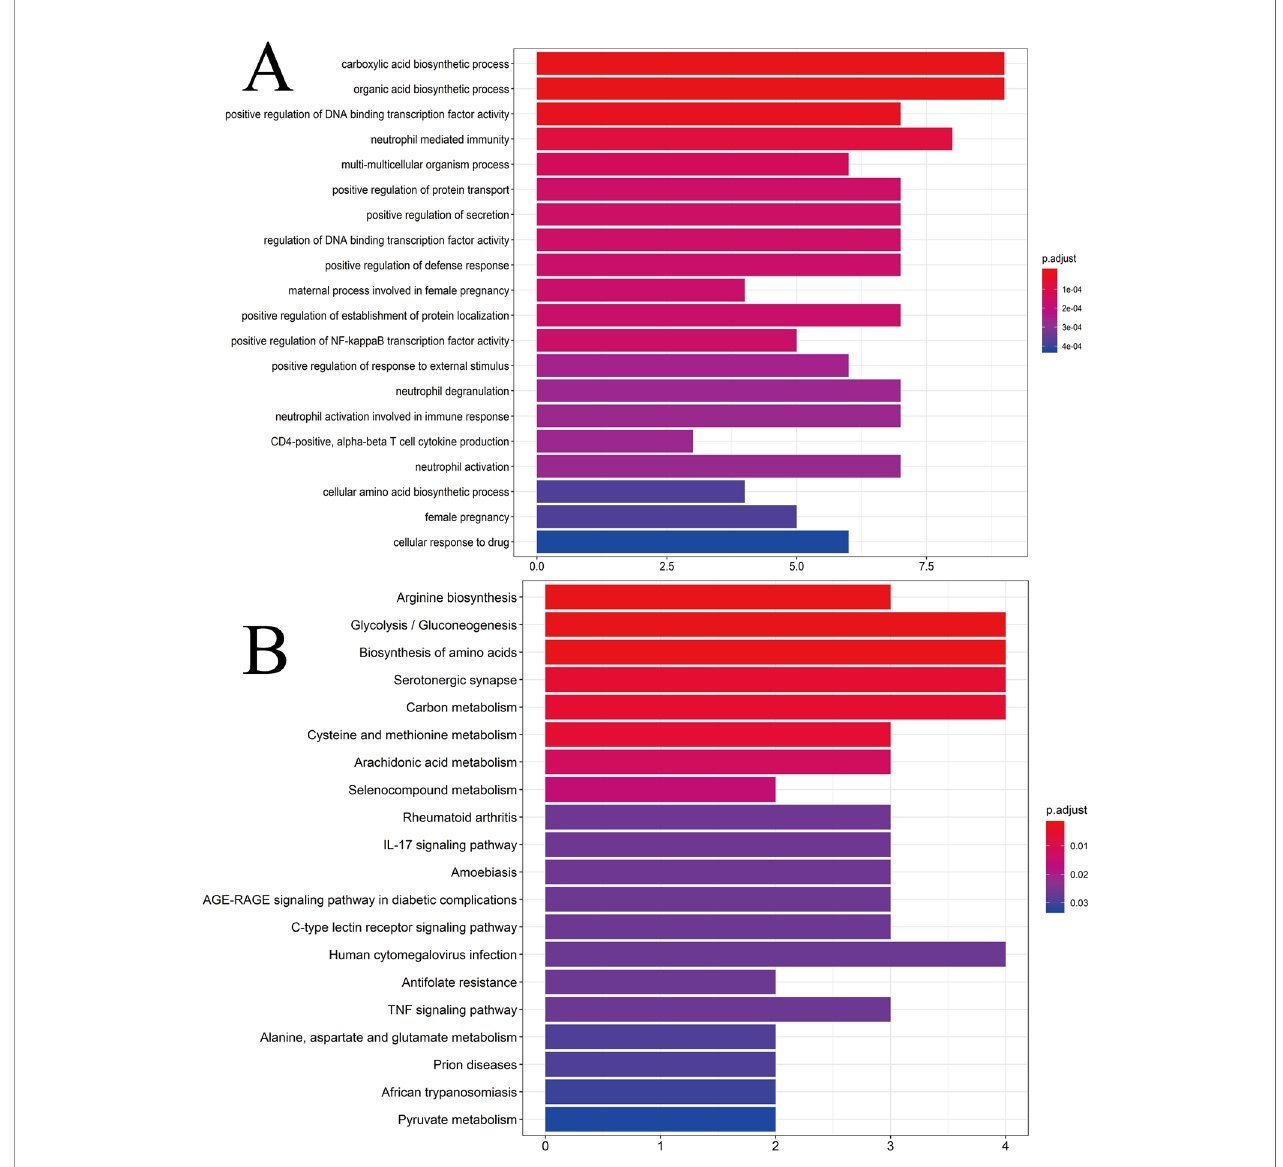
FIGURE 4 | (A) GO analyses of the 25 gene symbols associated with chronic gastritis. The x-axis represents signi fi cant enrichment in the counts of these terms. The y-axis represents the categories of “ biological process ” in the GO of the target genes ( p < 0.01). (B) KEGG pathway enrichment analyses. The x-axis represents the counts of the target symbols in each pathway; the y-axis represents the main pathways ( p <